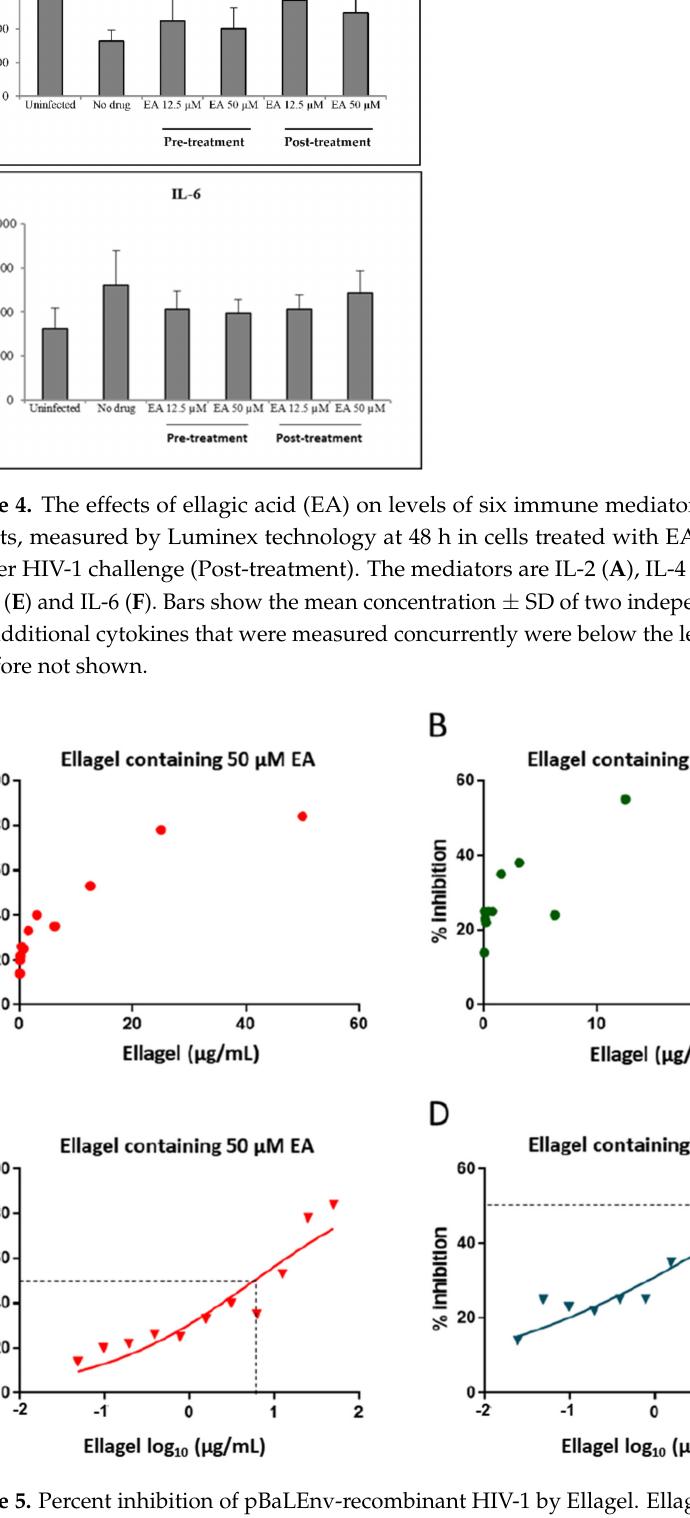
Figure 5. Percent inhibition of pBaLEnv-recombinant HIV-1 by Ellagel. Ellagel was formulated with either 25 µ M or 50 µ M of ellagic acid (EA). Then, various concentrations of Ellagel were used in